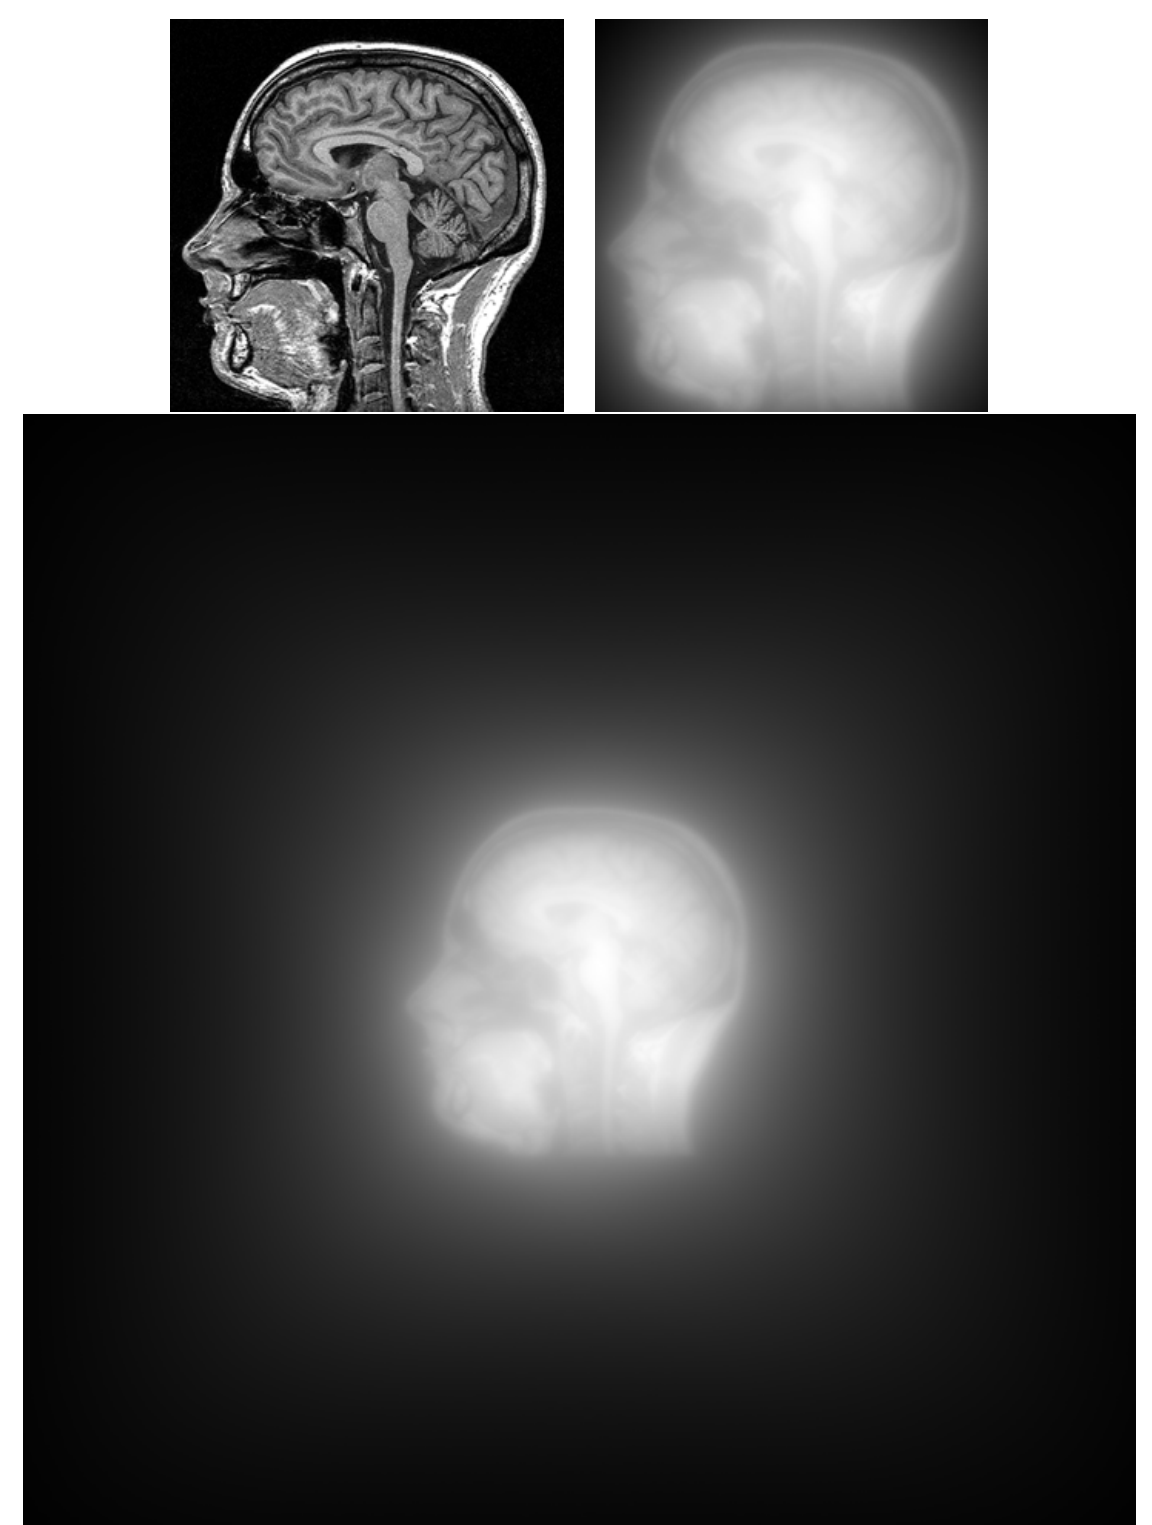
Figure 8. Top row, input image and conventional backprojection. Bottom row, extended